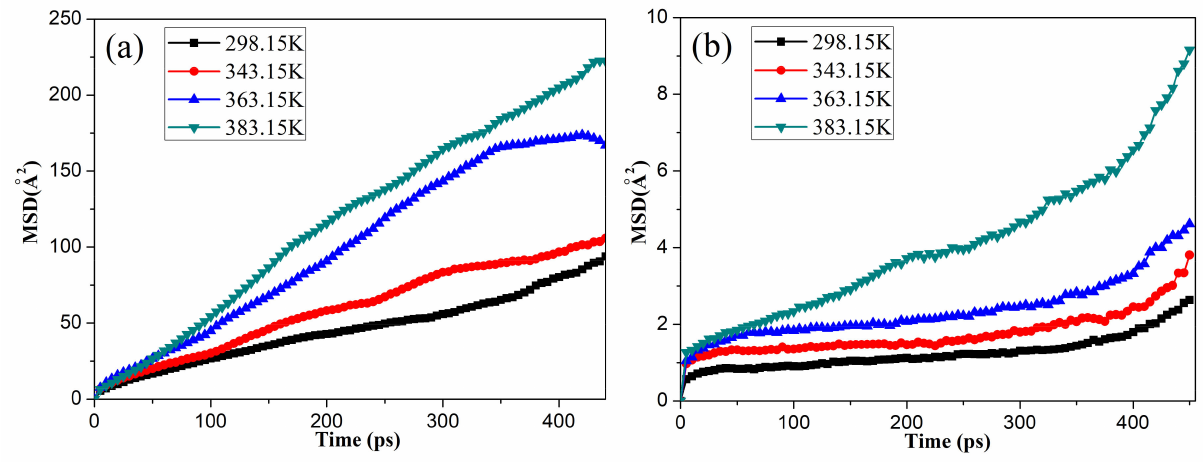
Figure 4. Changes in the mean square displacement ( MSD ) of the oxygen molecules in the unaged NBR under the free ( a ) and compression ( b )